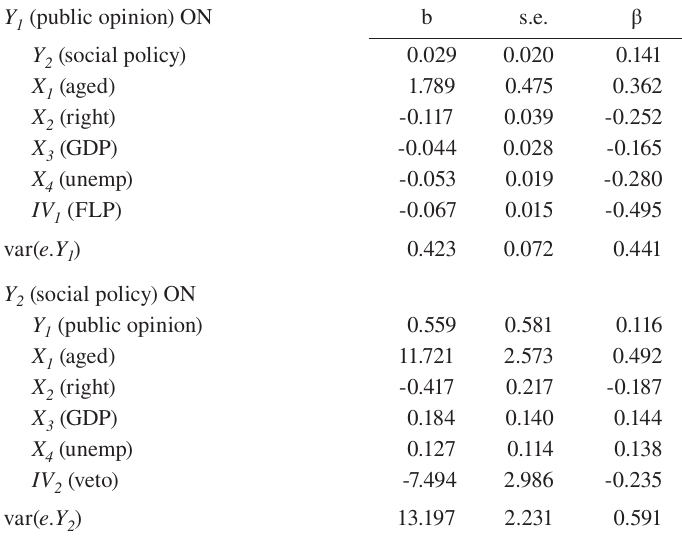
Results from Separate Unidirectional